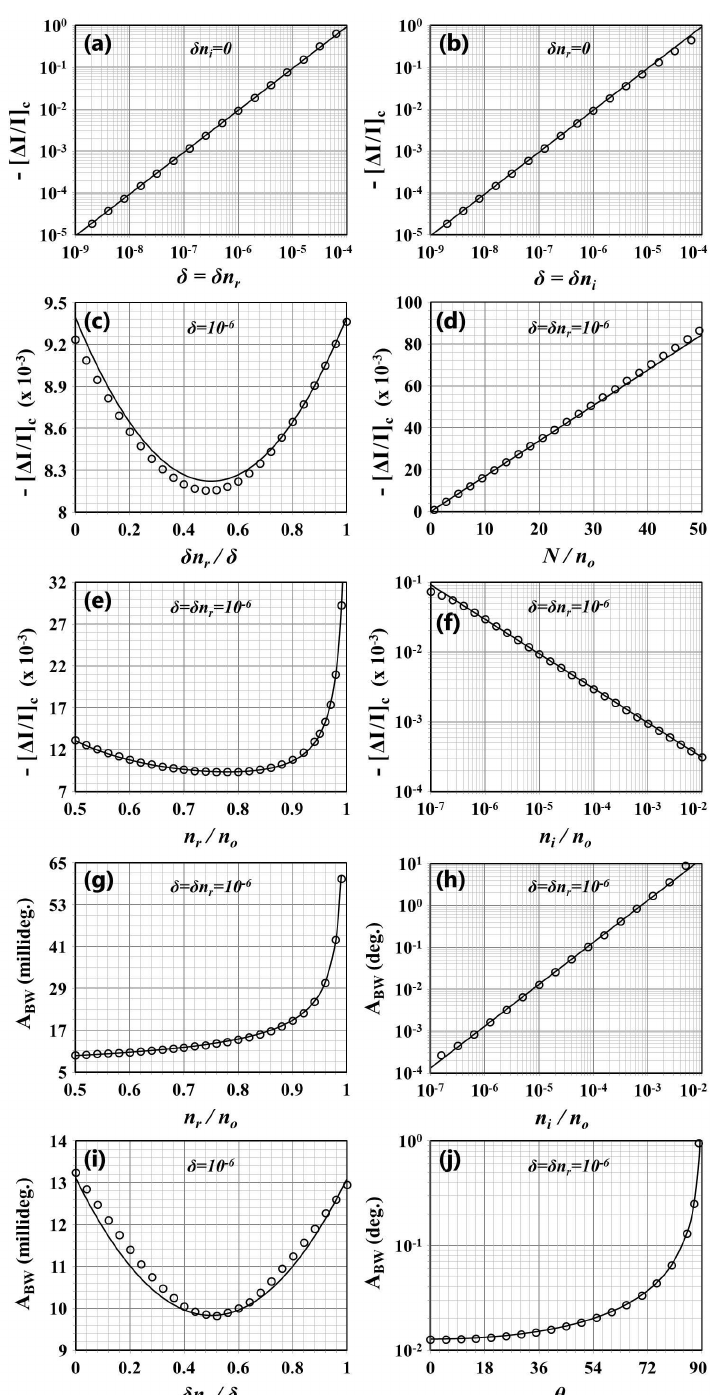
(cid:2) ∆ (cid:3) I / I Figure 3. Output signal and angular acceptance bandwidth A BW , as a function of relevant c variables. Open circles correspond to exact values derived from signal-versus-incidence-angle plots, by use of Equations (2) and (6); solid lines are estimates from the empirical Equations (7) and (9). Throughout, values of parameters other than x-axis variables are: n air = 1, n r / n o = 0.75, n i / n o = 10 − 5 , N / n o = 1/0.18. Specifics on the index perturbation values δ , δ n r and δ n i are provided in each individual plot. A BW calculations assumed n o = 2.16; the angle α was properly varied to maintain a constant θ c = 15 ◦ in ( g ), ( h , i ), but a properly scalable θ c in ( j ). Respective values for are irrelevant, since they do not affect the results, but are reported for the sake of completeness: n o = 1.8 and α = 81 ◦